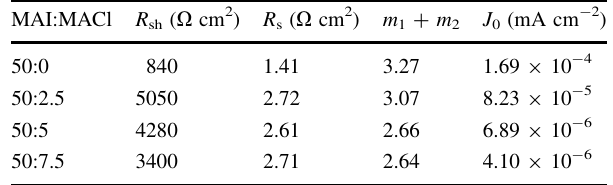
Table 3 R sh , R s , m 1 ? m 2 and J 0 derived from Fig. 3b, c Table 2 Photovoltaic performance of perovskite solar cells fabri-